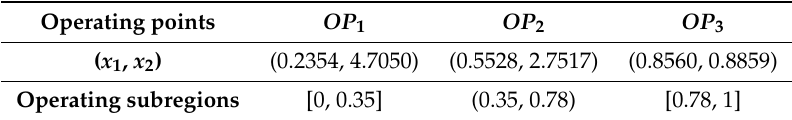
Table 2. Coordinates of three operating points and their operating